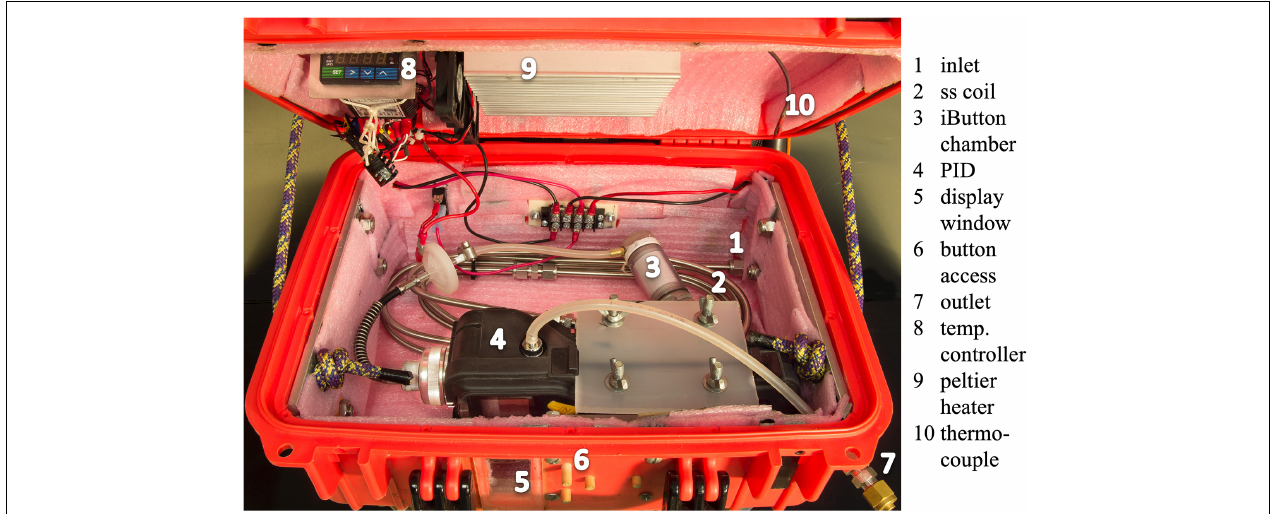
FIGURE 4 | The temperature-control box provides thermal regulation of the PID and sample gas. The PID is fixed inside an insulated enclosure with a battery-powered Peltier heater. A thermocouple-equipped thermostat regulates the heater to maintain a fixed above-ambient temperature inside the enclosure. Sample gas enters the enclosure by tubing connection to a bulkhead union. Sample gas is pre-heated to match the enclosure temperature via coils of stainless steel (ss) tubing. Gas temperature and humidity are measured with an iButton in a PTFE-insulated chamber upstream of the PID. An acrylic window enables viewing of the PID display. Wooden pins at the box interface provide access to the buttons on the PID without opening the enclosure. PID sample exhaust is piped to an outlet port, which can be connected to alternative sampling media (e.g., bags, adsorption